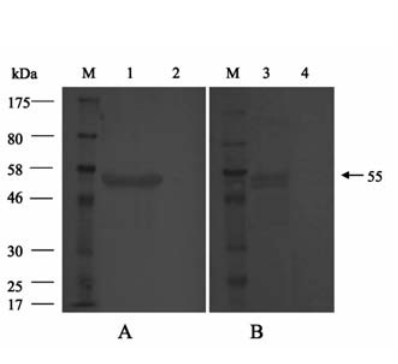
Figure 5. The obtained antiserum reacted in Western immunoblots with the same protein both in purified EhV-99B1 virions (A) and host cells sample at 25 h post EhV infection (B) . Lane M, Mr markers, sizes of which are indicated to the left. Line 1, puri- fied EhV-99B1 virions; line 2, negative con- trol: same treatment as in lane 1 but with- out Major Capsid Protein (MCP) anti- serum. Lines 3-4, host cells sample at 25 h post EhV infection and uninfected